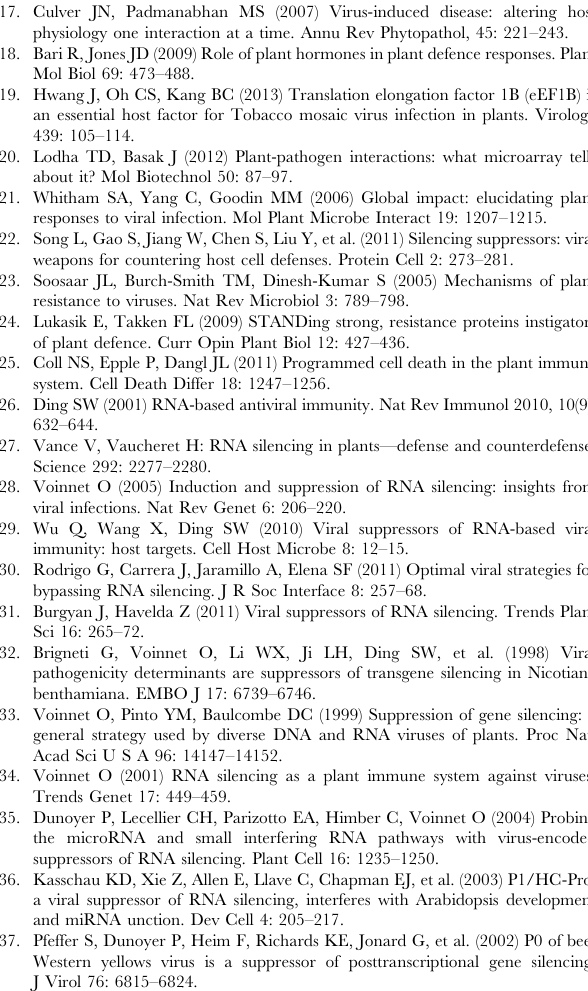
Table S15 Different down-regulated transcripts in the BRB-TMV transgenic plants after subtracting the up- regulated transcripts from other ARB-TMV, TMVi and different VRS expressing transgenic tobacco plants (HcPro, AC2 and P25). Table S16 Primers used in RT-qPCR experiment for validation of microarray